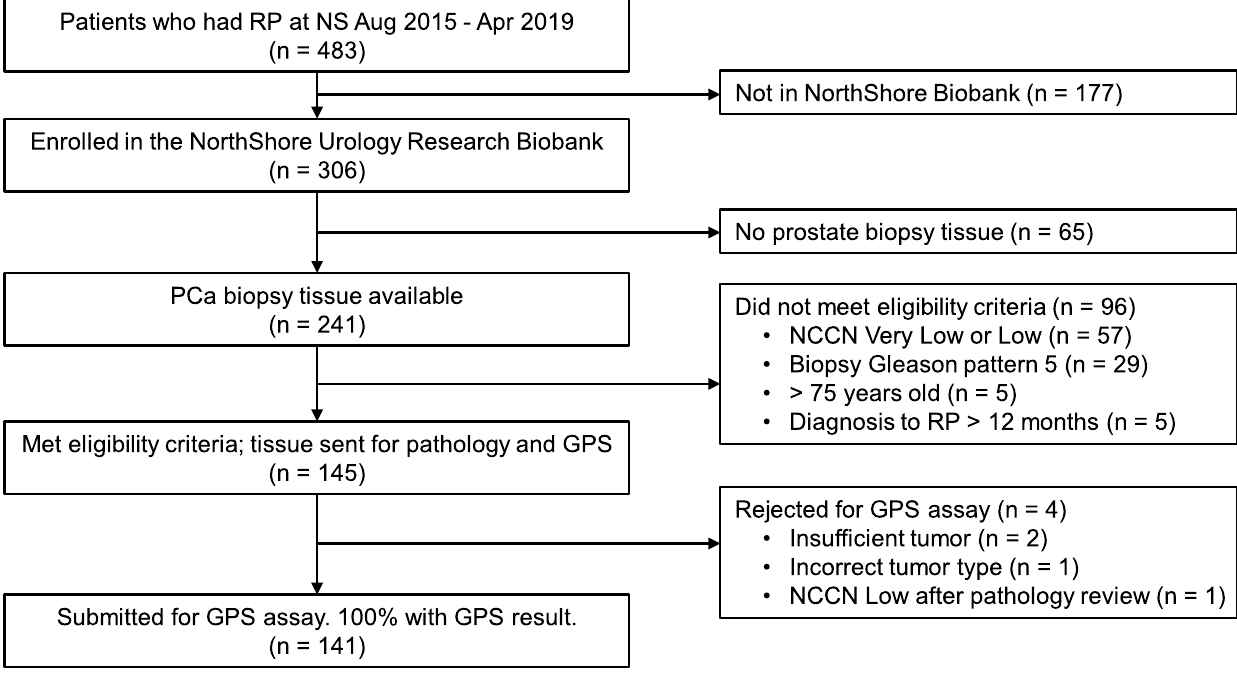
PLOS ONE | https://doi.org/10.1371/journal.pone.0273782 September 1,